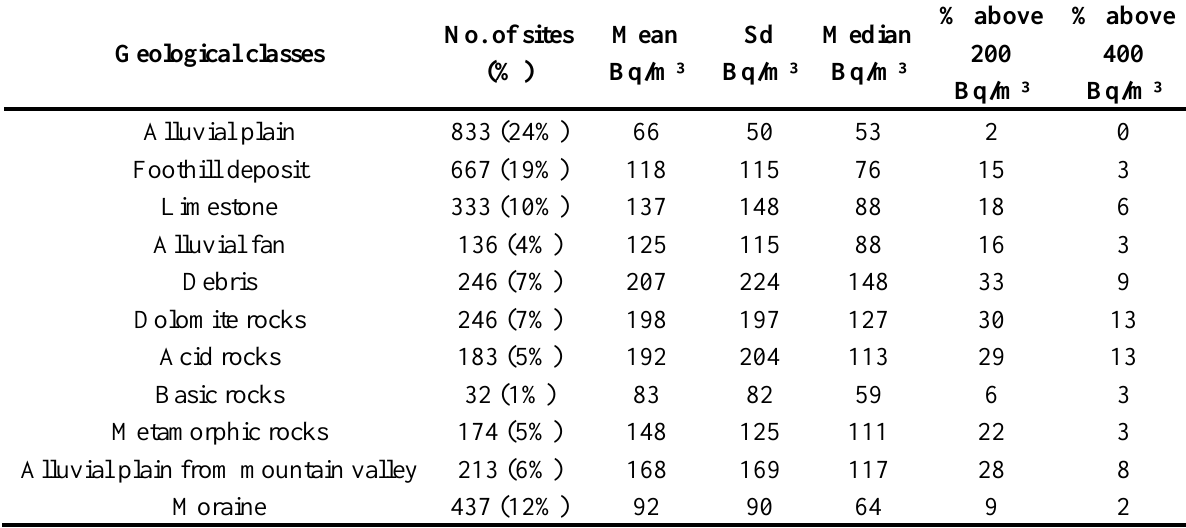
Table 2. Summary statistics of indoor radon concentration by geological